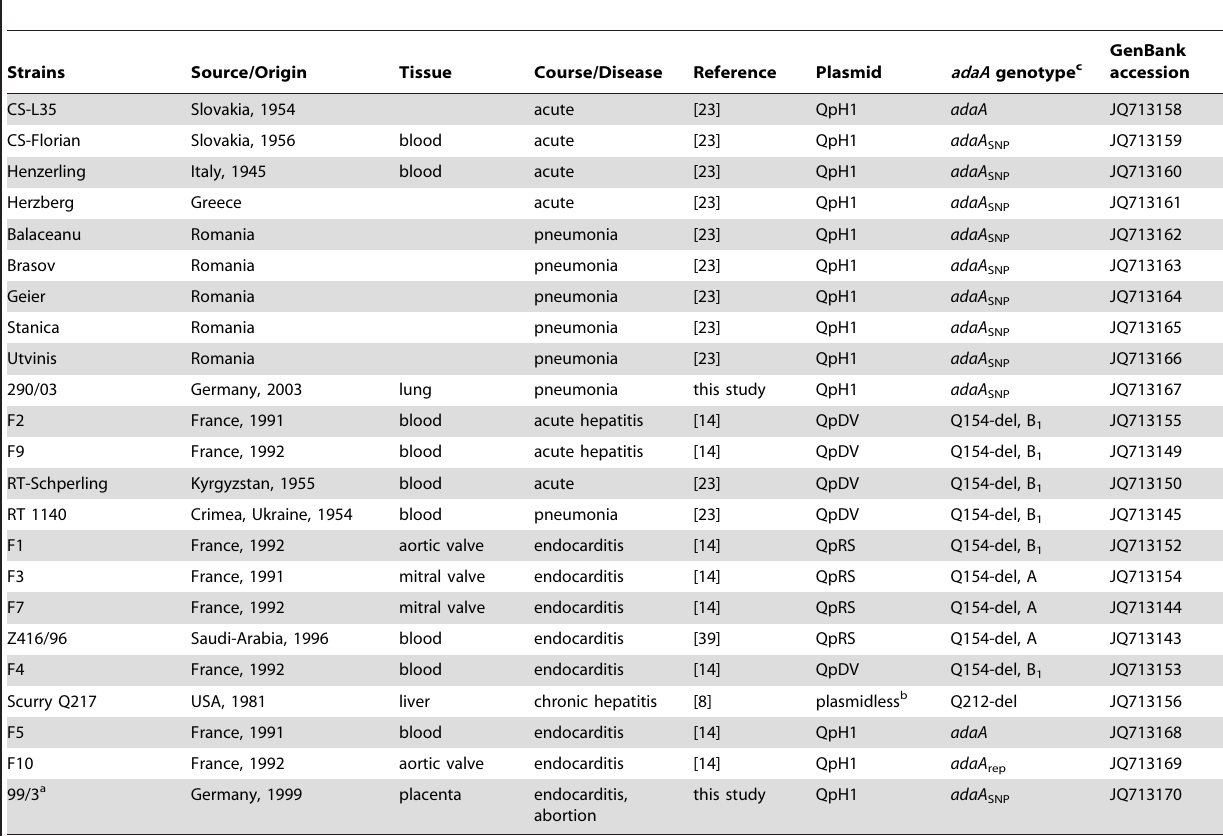
Table 1. adaA genotypes of human Coxiella burnetii isolates from acute and chronic Q fever.